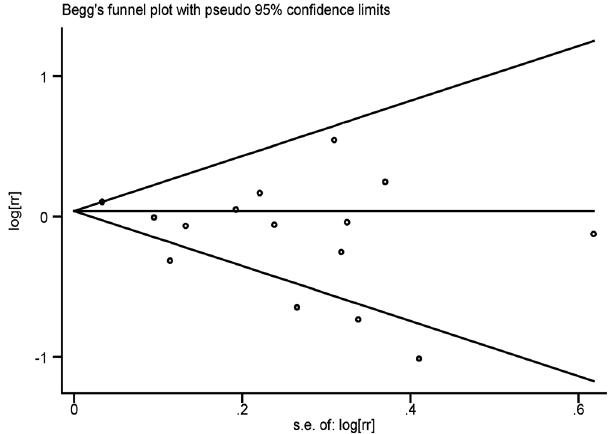
Figure 3. Funnel plot for the association between alcohol intake and the risk of DR in all the included studies. No significant publication bias was detected through pooling the 15 observational studies together.